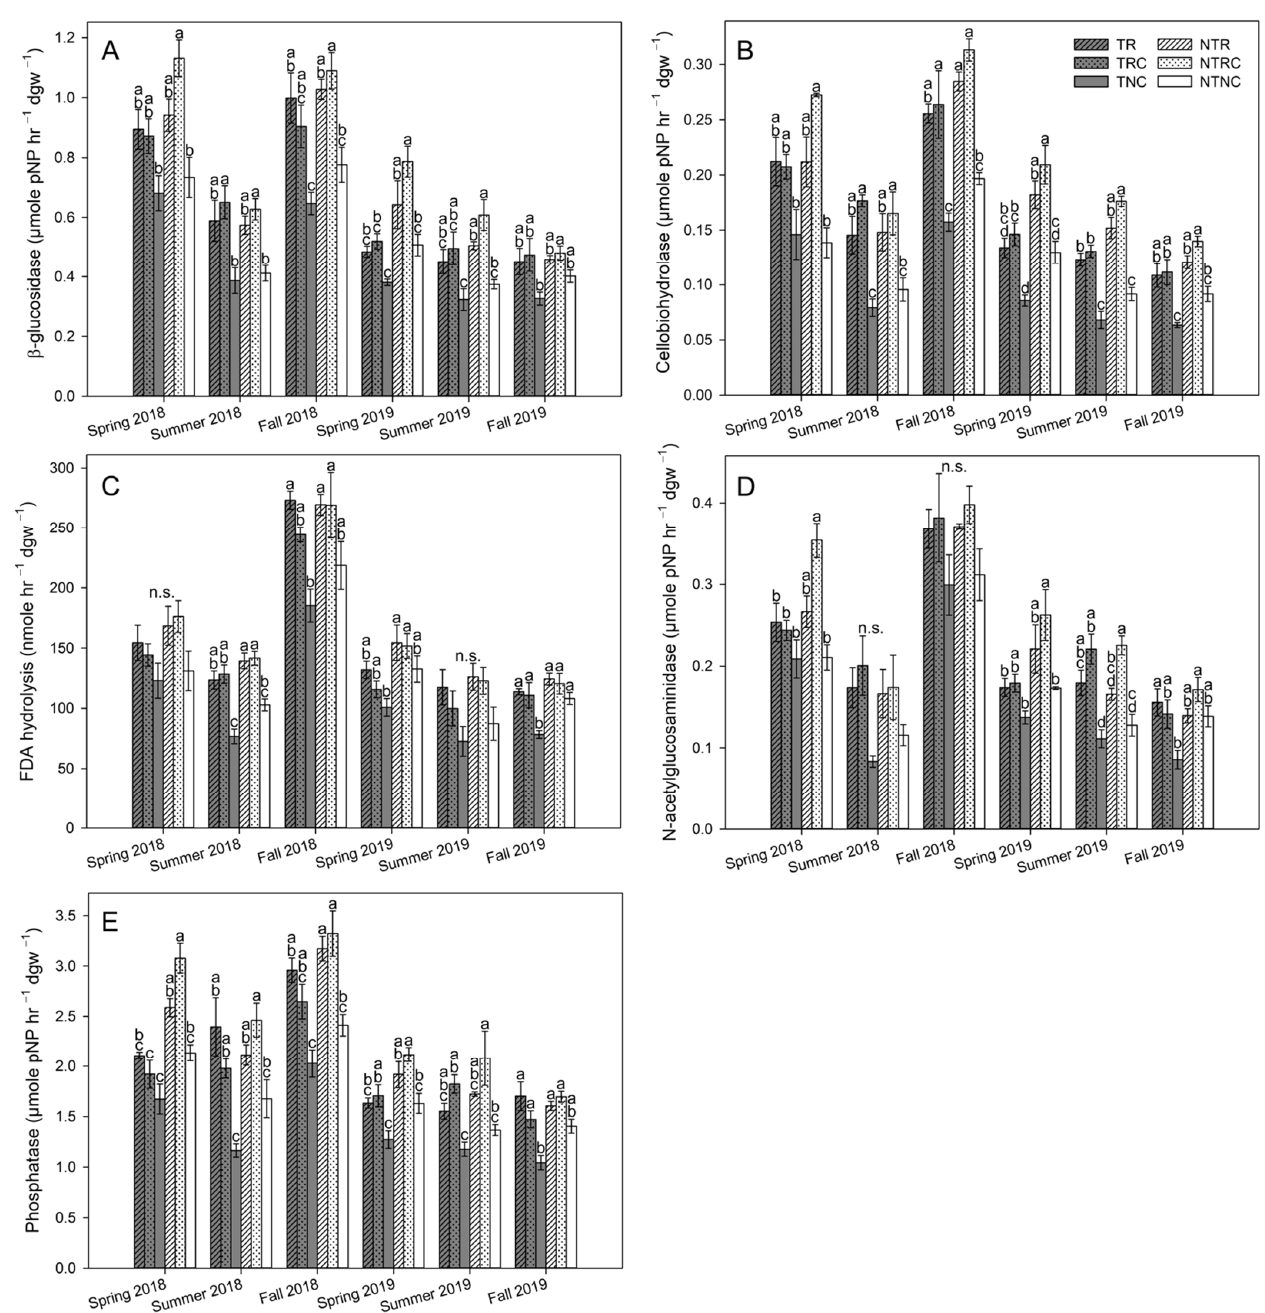
Figure 5. Activities of β -glucosidase ( A ), cellobiohydrolase ( B ), FDA hydrolysis ( C ), N-acetylglucosaminidase ( D ), and phosphatase ( E ) in 0–5 cm soil from till (T) and no-till (NT) plots planted with winter cover crop treatments of rye only (R), rye+clover (RC), and no cover (NC) during the 2018 and 2019 soybean growing seasons. Values represent the mean ± standard error. Statistical significance between treatments for each timepoint are denoted by different letters ( α = 0.05). Timepoints marked with n.s. indicated no significant differences between pairwise comparisons.